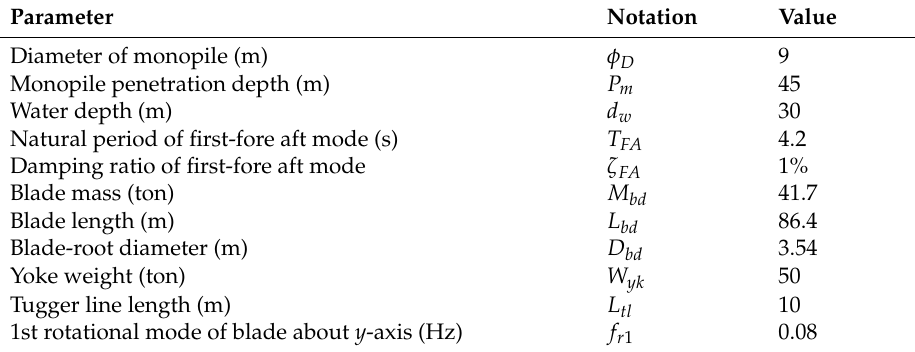
Table 1. Modelling parameters of installation system used in HAWC2